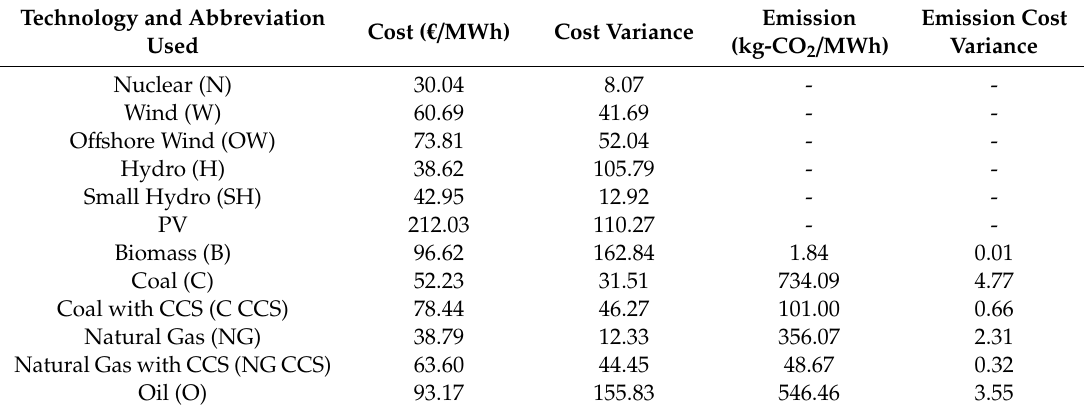
Table 1. Cost, emission, and standard deviations by technology. Source: Authors’ own work, based on data collected from DeLlano et al. (2014, 2015)